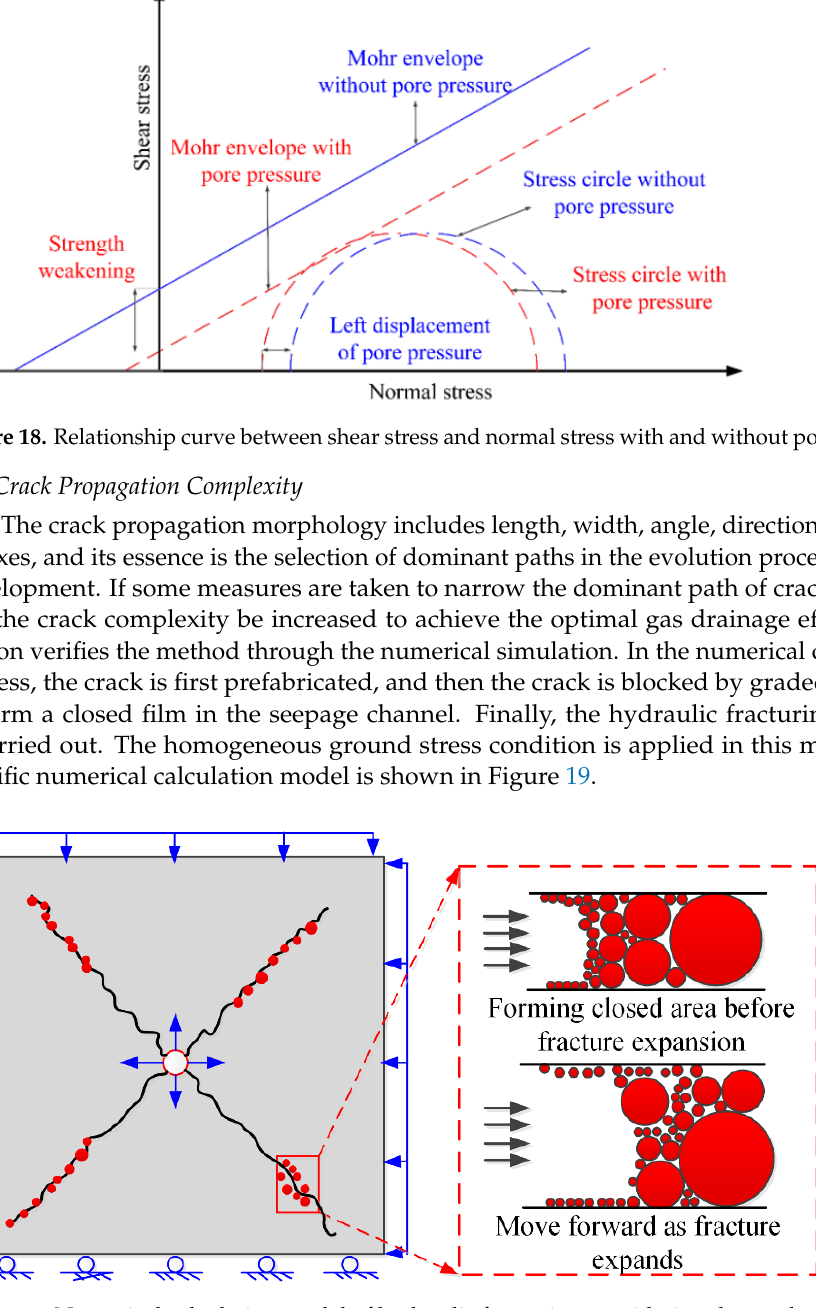
Figure 19. Numerical calculation model of hydraulic fracturing considering the crack sealing with special graded particles.